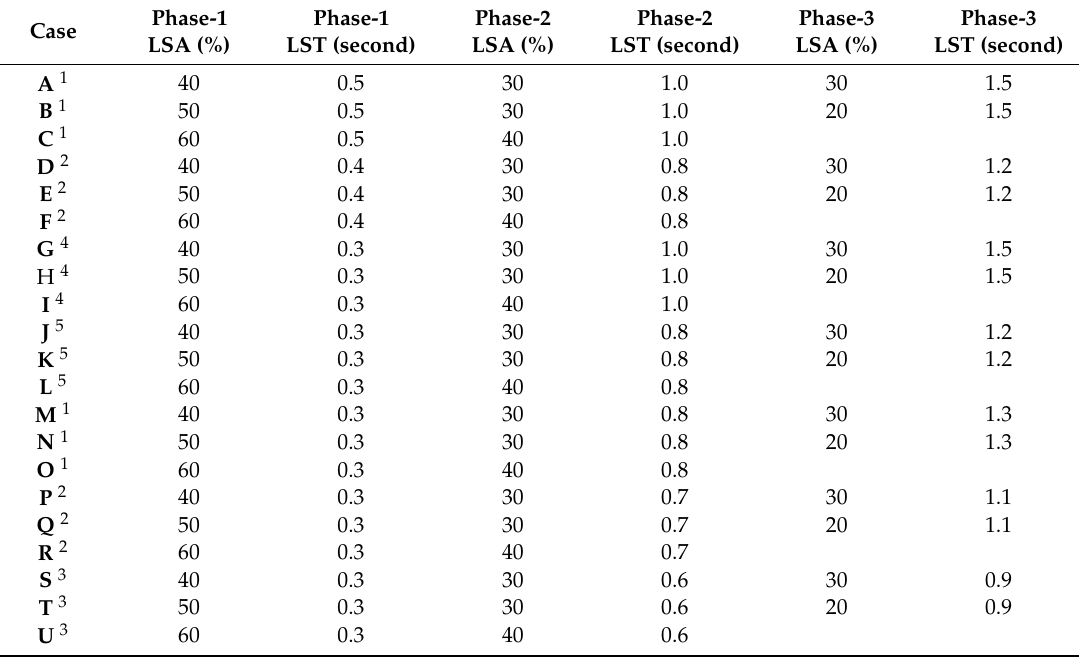
Table 4. Case study for selection of LSA and